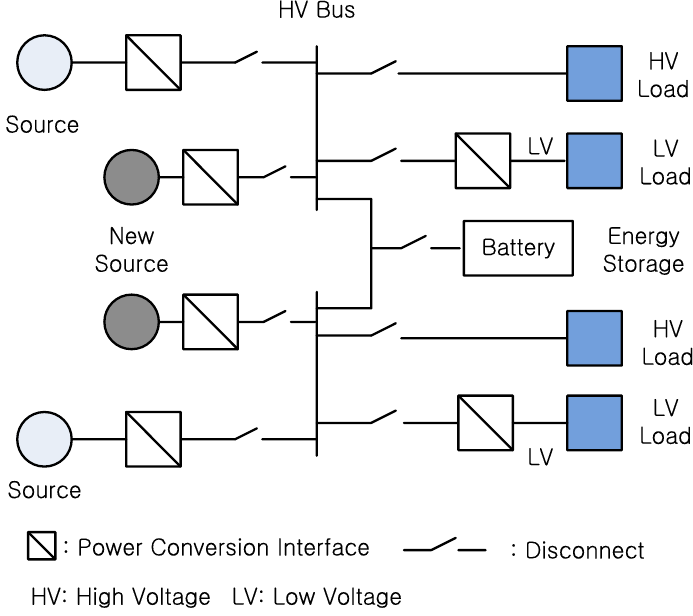
Figure 2. Configuration of a generalized EPS in an MEA.